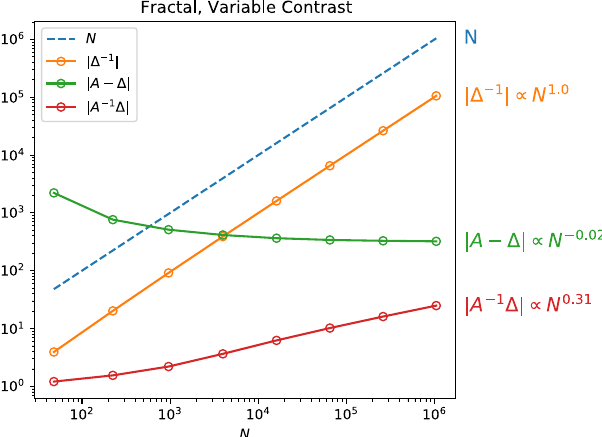
Figure 5. Scaling of the components of the fast-inverse QLS algorithm for problems of increasing size for a fractal fracture network with high permeability contrast.